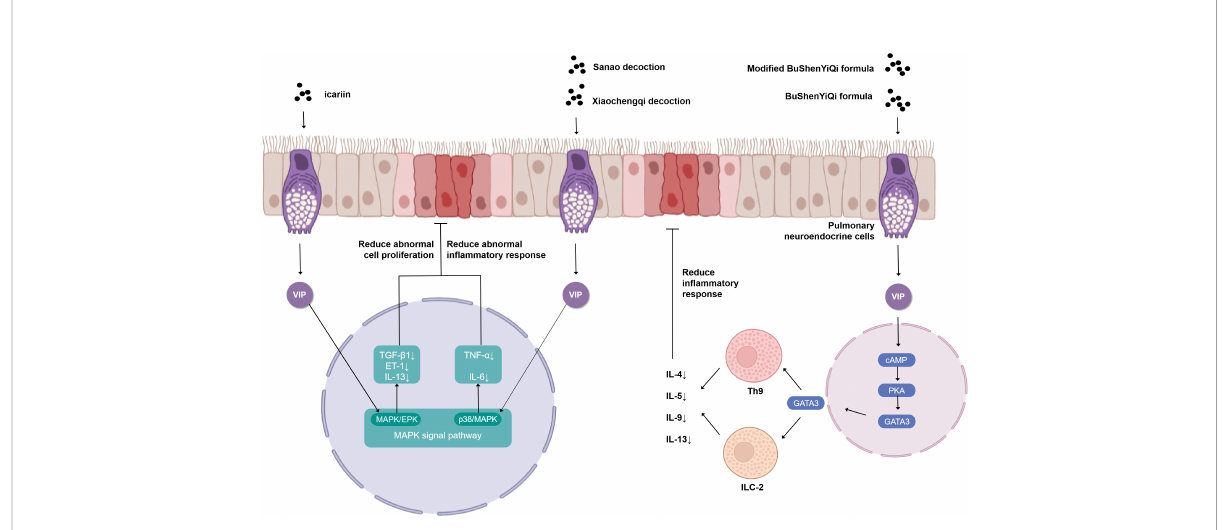
FIGURE 2 Simpli fi ed schematic diagram of cellular endocrine mechanism of vasoactivepeptide in the treatment of asthma with traditional Chinese